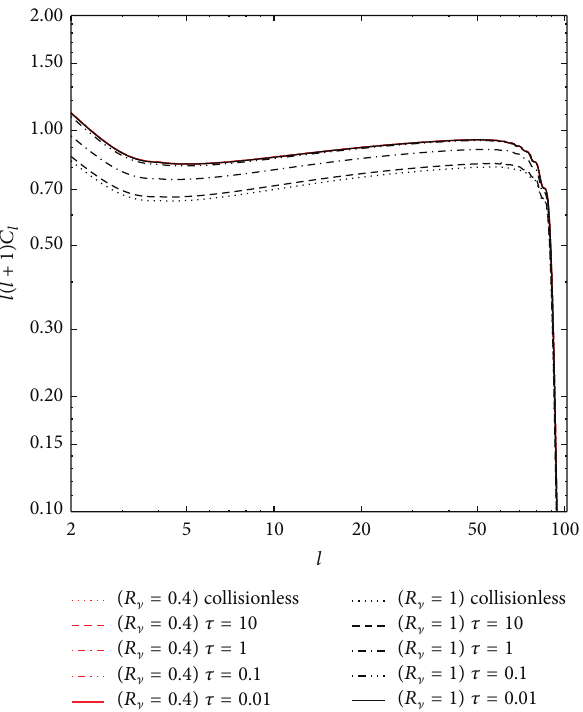
Figure 6: Tensor contribution to the angular power spectrum for the RMD scenario in case of including the collision terms. Results are for 𝜏 = 0.01, 0.1, 1 , and 10 , in units of 𝜂 0 , and for the collisionless case. Notice that, for decreasing values of the 𝜏 parameter, the suppression due to a huge number of neutrinos (d.o.f.) is not so relevant; that is, the increasing collision effect attenuates the damping effect on the tensor mode propagation and it is reflected on the tensor contribution to the angular power spectrum.